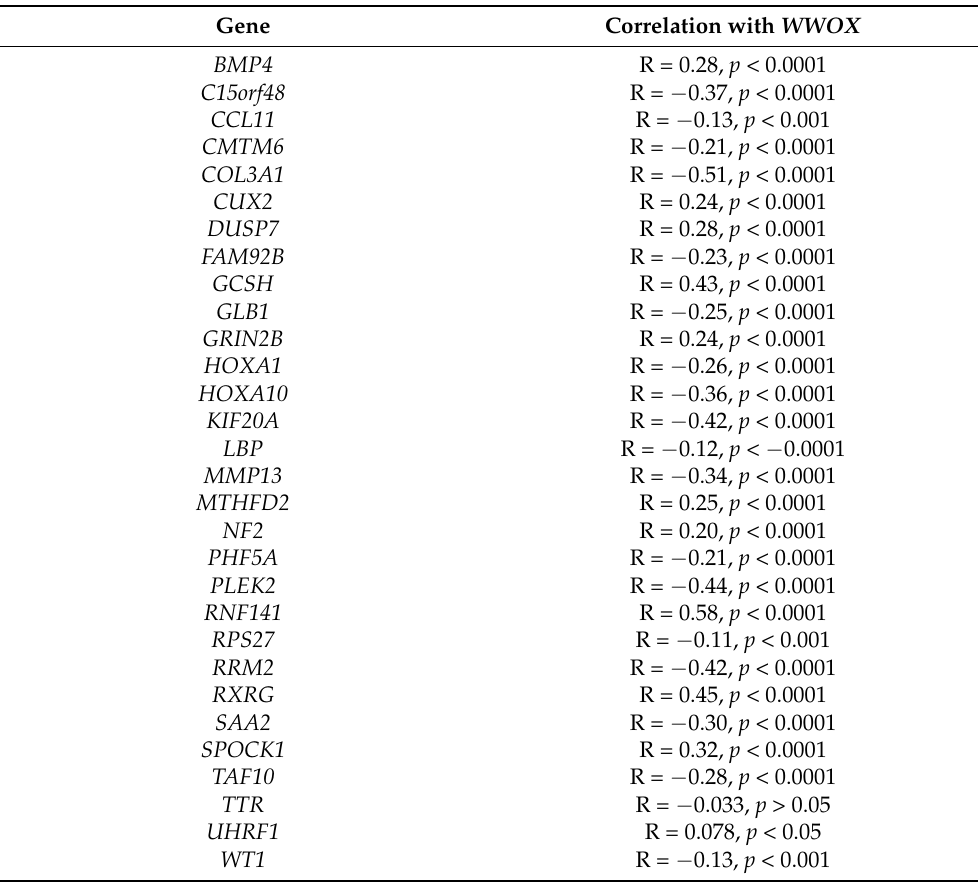
Table 3. Correlation analysis of the top genes with WWOX